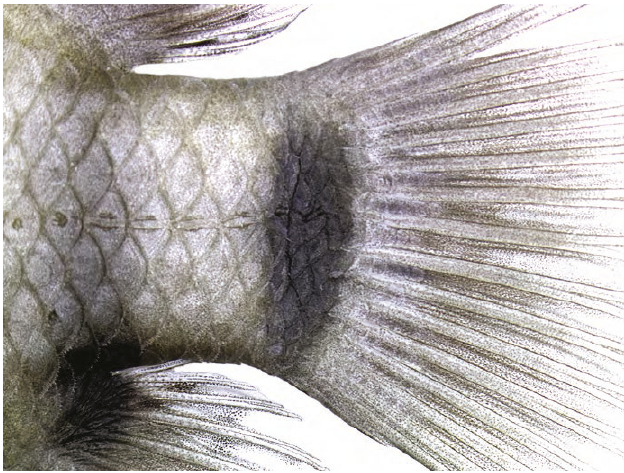
Figure 7: Detail of caudal peduncle of A . nigrofasciata (MPUJ 8463) show- ing the presence of secondary pores and caudal blotch on caudal fin.